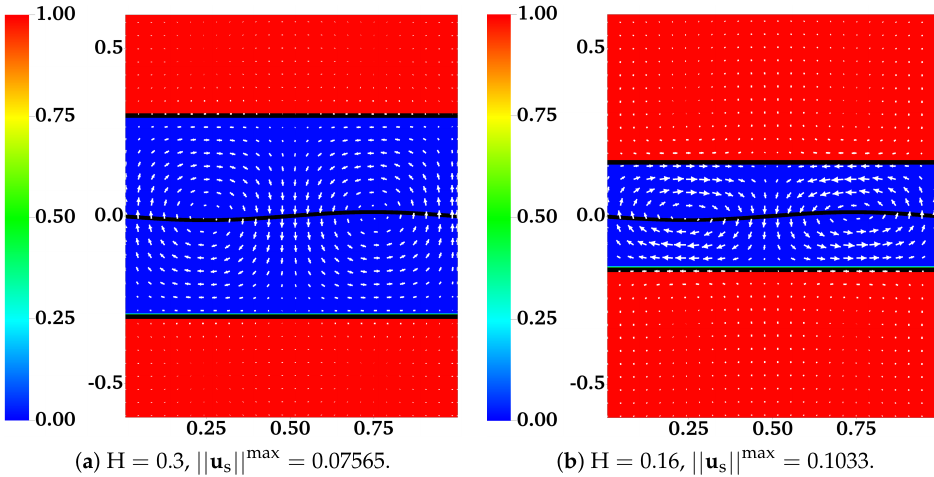
Figure 2. Distribution of network volume fraction θ n and fluid velocity u s at t = 0.5 for different H. All vectors have the same scale. The viscosity ratio between the two fluids is β = 0.5.